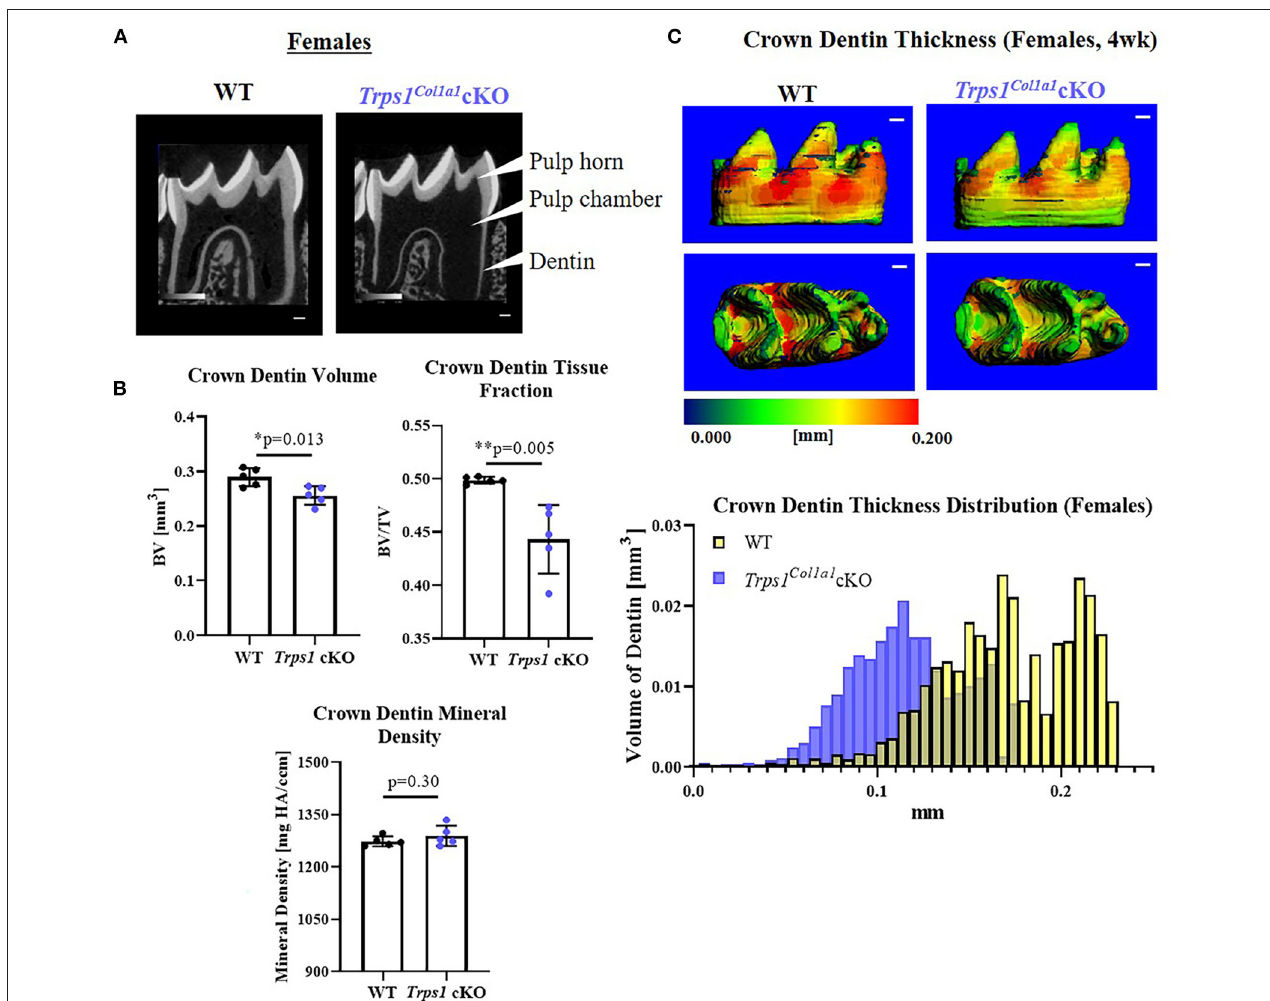
FIGURE 5 | Quantitative µ CT analyses of crown dentin of mandibular first molars of 4 wk old WT and Trps1 Col1a1 cKO females. (A) Representative 2D µ CT images showing reduced dentin thickness (white arrowheads) and enlarged pulp chambers in Trps1 Col1a1 cKO females compared to WT. (B) Quantification of crown dentin volume, dentin tissue fraction in the total crown volume and mineral density. Mean values ± SD and individual data points (dots, N = 5/genotype) are shown; * p < 0.05 and ** p < 0.01. (C) Representative 3D µ CT images of the crown dentin; scale bar = 100 µ m. The dentin was pseudo-colored based on the distribution of tissue thickness. The corresponding tissue thickness color scale is shown below the images. The graph below the 3D images shows the comparison of the quantity (volume) of the crown dentin with specific thickness in WT and Trps1 Col1a1 cKO